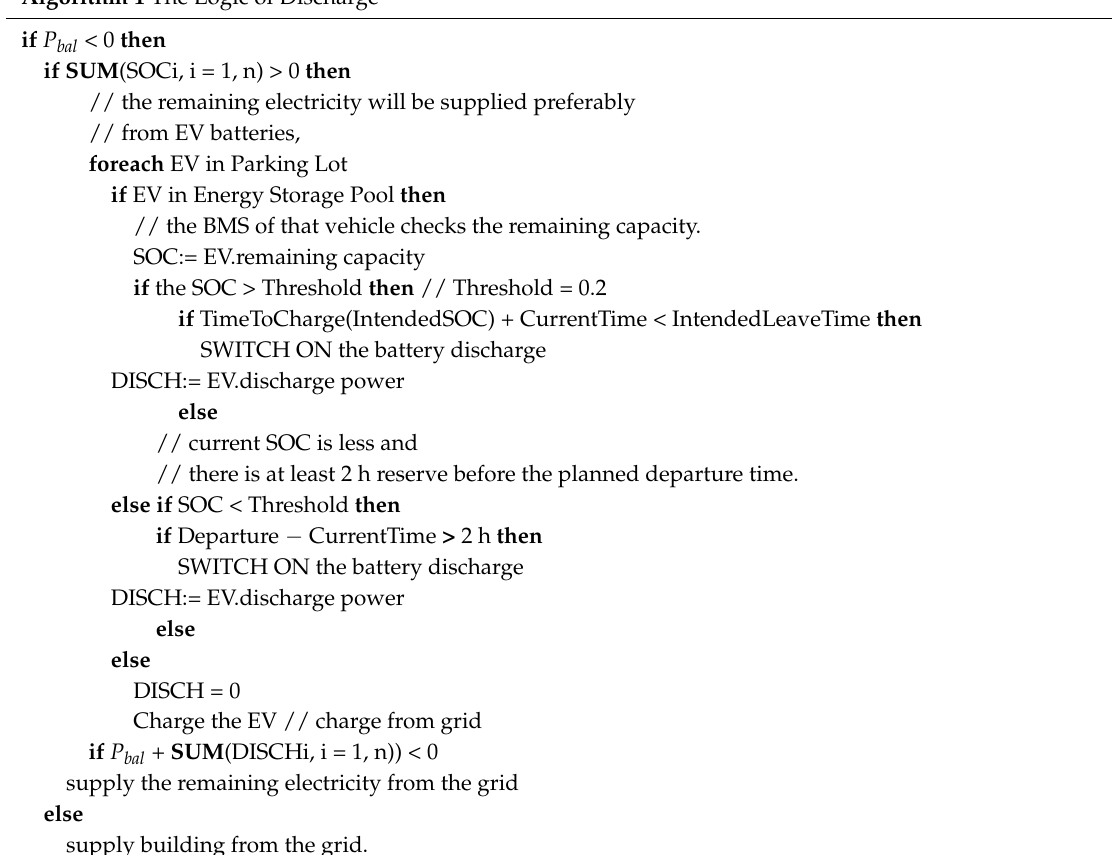
Algorithm 1 The Logic of